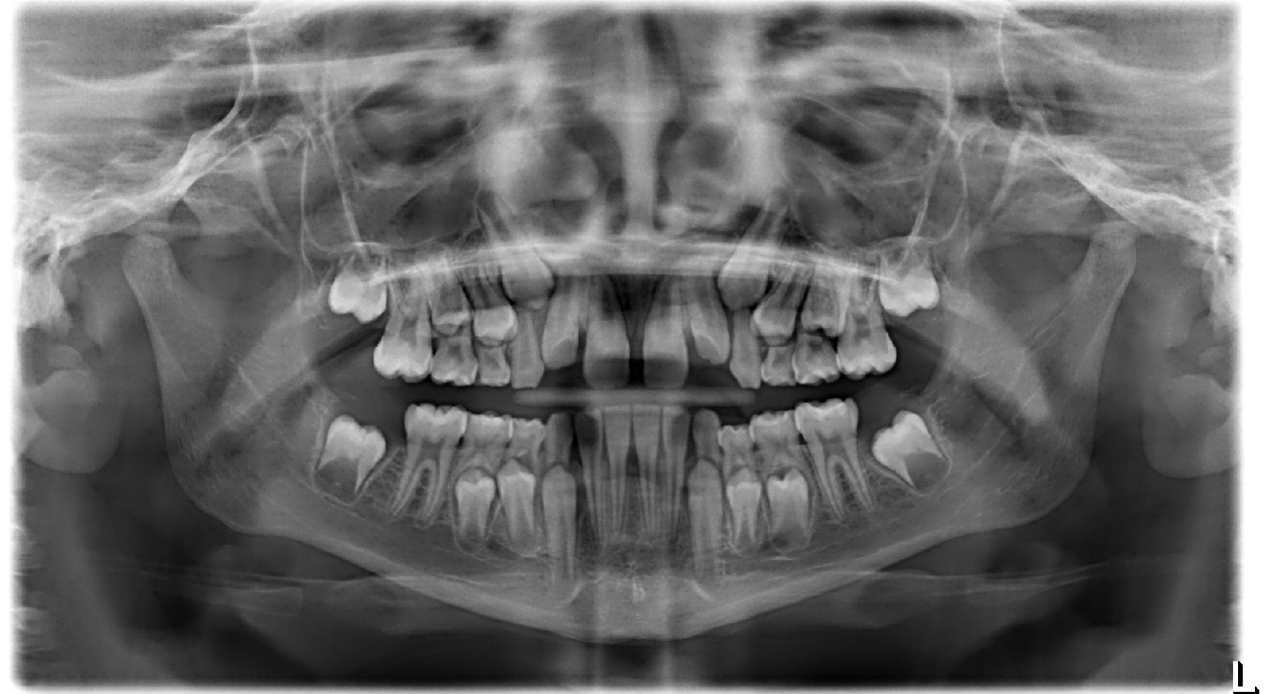
Figure 19. Radiographs of the subject at the end of the treatment. Orthopantomography X-ray after treatment (8-year-old).